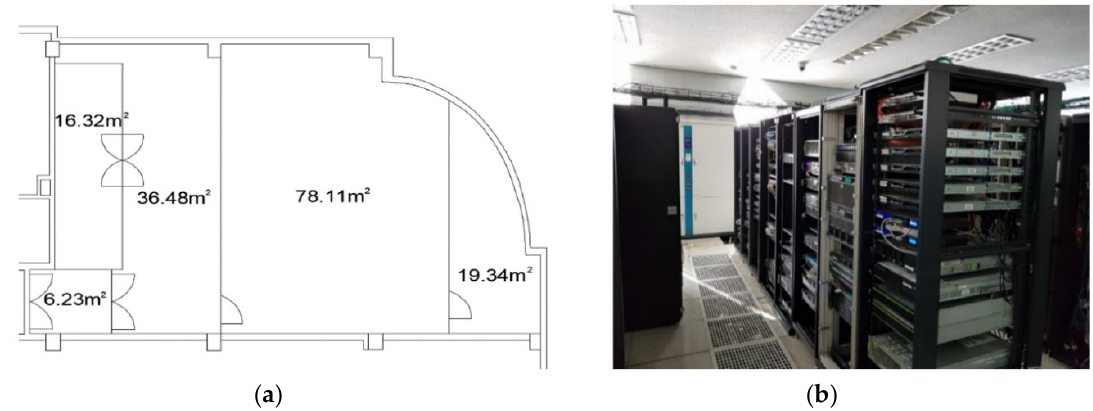
Figure 1. Model of the computer room considered in this study: ( a ) layout of the room; ( b ) photograph of the computer room.